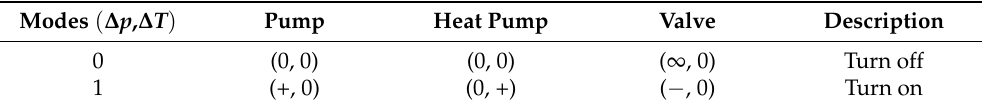
Table 1. Operating modes of typical actuators and components in an energy system. ( ∆ p , ∆ T ) :